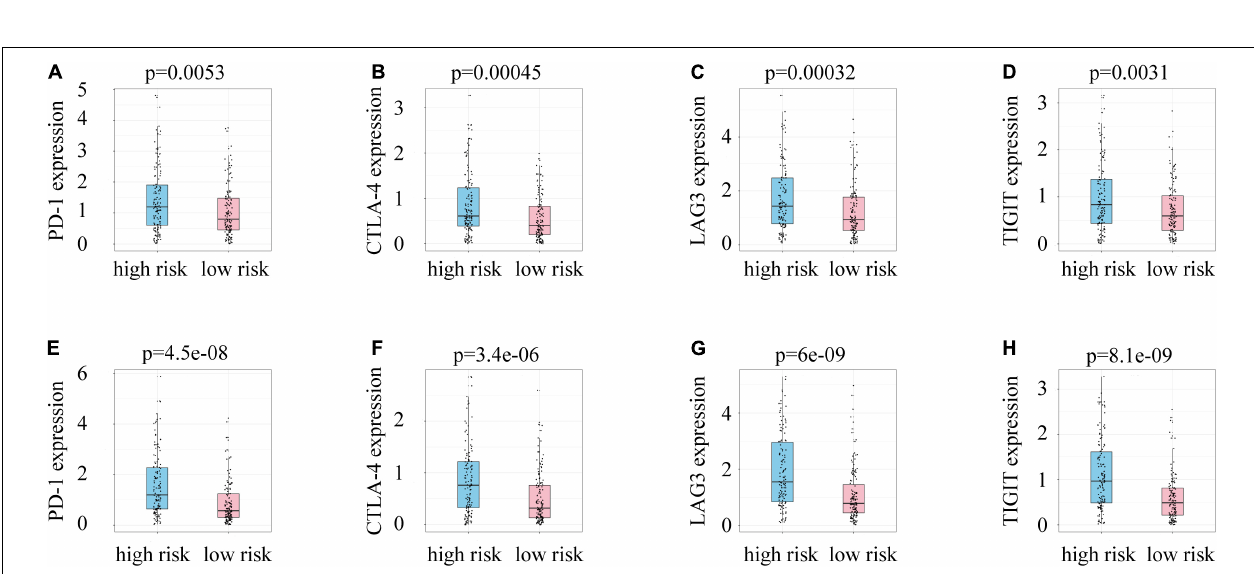
FIGURE 6 | Risk score correlations with overall survival by univariate Cox regression analysis in (A) the training group and (B) the test group. Risk score as an independent prognostic indicator (by multivariate Cox regression analysis) in (C) the training group and (D) the test group.